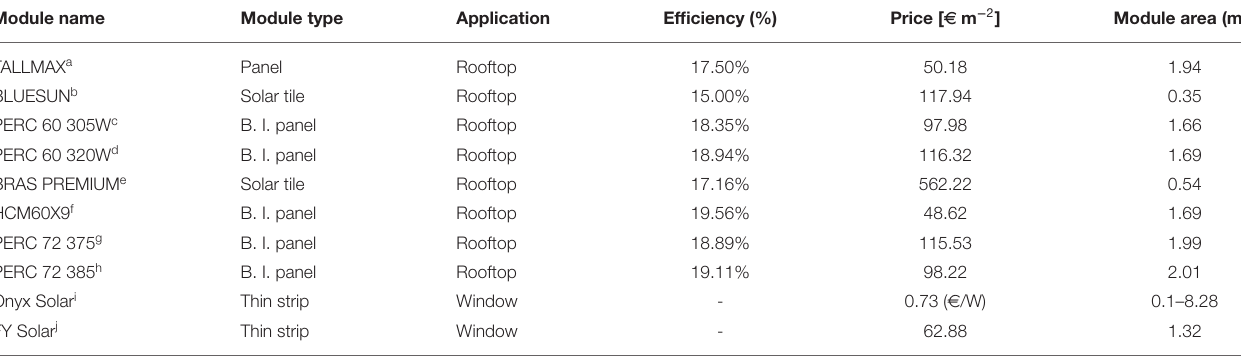
TABLE 3 | Key characteristics and prices of the considered module